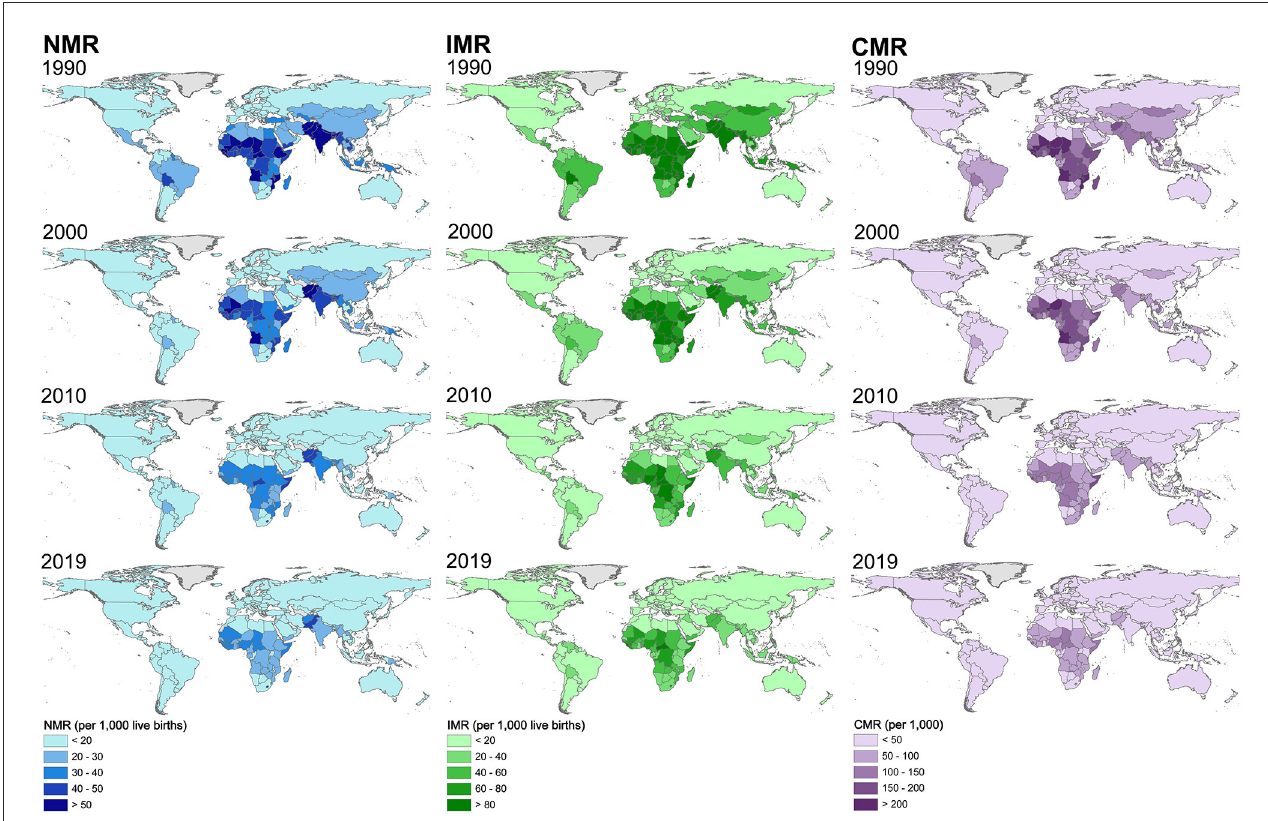
FIGURE3 Spatial distribution of NMR, IMR, and CMR in each country in the world from 1990 to 2019 with a 10-year